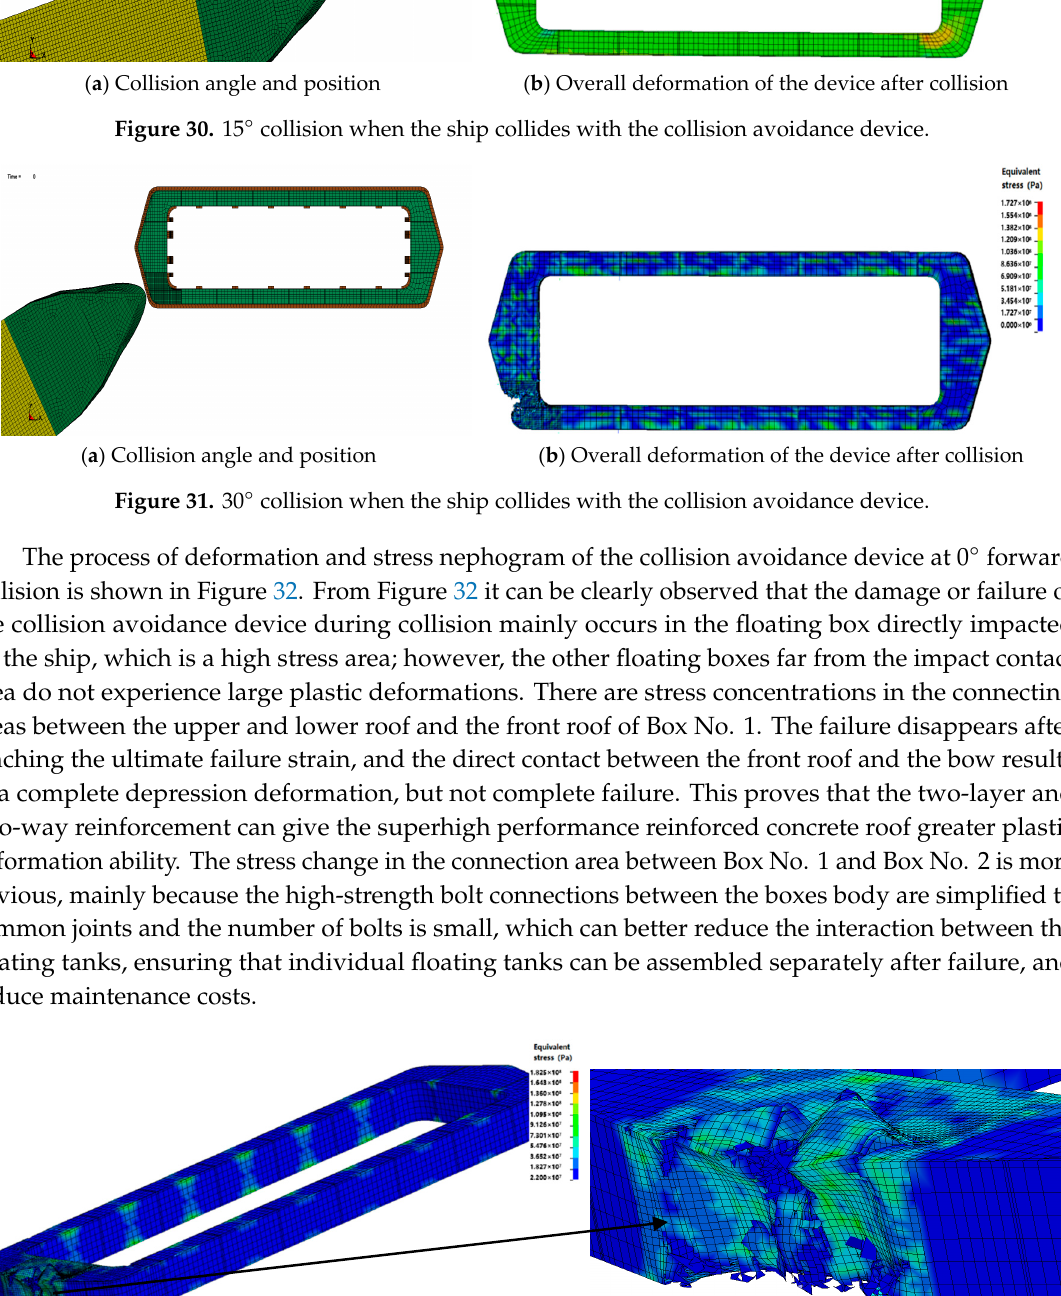
Figure 32. Deformation and stress nephogram of the collision avoidance device at 0° forward collision.